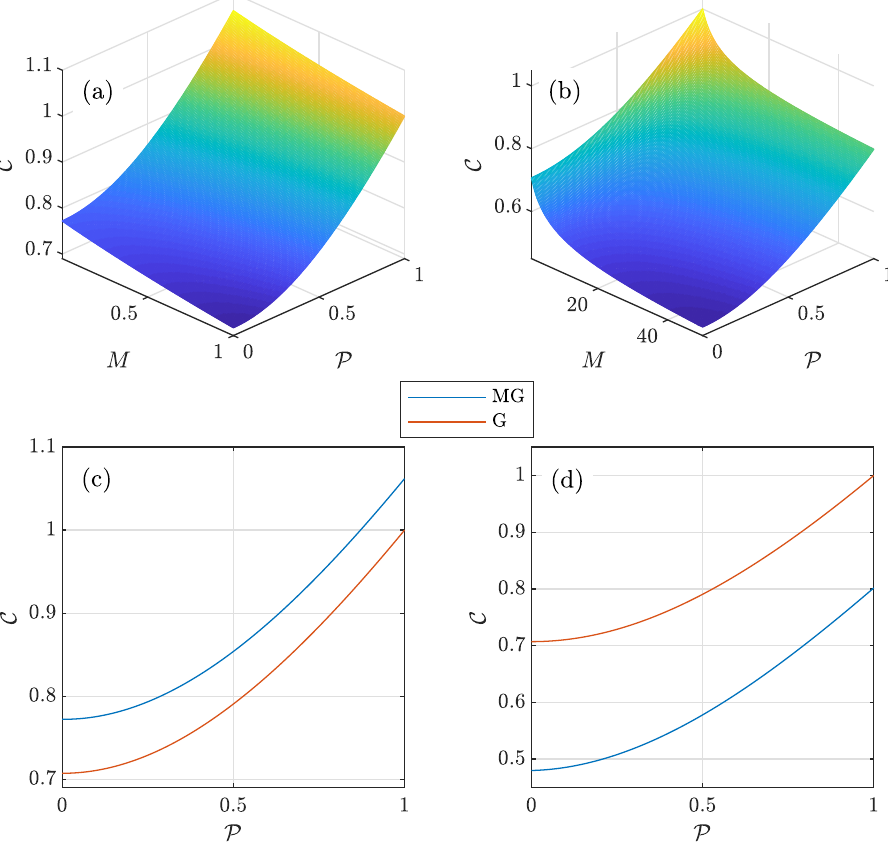
Figure 1. Contrast of partially polarized MG speckle versus shape parameter M and degree of polarization P : ( a ) M ≤ 1, ( b ) M ≥ 1, ( c ) M → 0, and ( d ) M → ∞